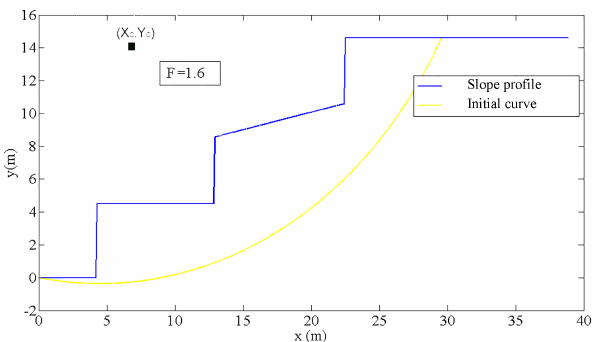
Figure 2. Idealized cross section of a slope. In this example, the centre coordinates are equal to x c = 7m, y c = 14m, and the lower cut has the slope coordinates (P1 point) equal to x t = 0m and t = 0m, data that the user introduces.